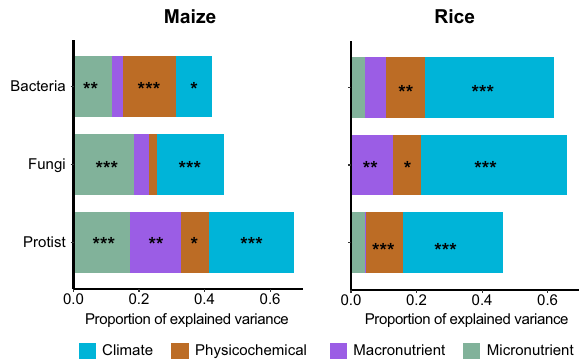
Fig. 1 Explained variance of bacterial, fungal and protistan communities in maize and paddy soils by environmental parameters using partial mantel test analysis. Input matrices with variables: climate (mean annual temperature, mean annual pre- cipitation), soil physicochemical properties (soil pH, CEC, sand, silt, clay, dissolved and total organic matter), macronutrients (total and available nitrogen, phosphorus, potassium and sulfur, nitrate and ammonia nitrogen) and micronutrients (total and available iron, zinc, copper, manganese). The signi fi cance of statistical test was conducted by partial mantel test analysis based on pearson correlation. Similar results were obtained using multiple regression on matrices (Supplementary Fig. 1). *** p < 0.001; ** p < 0.01; * p <